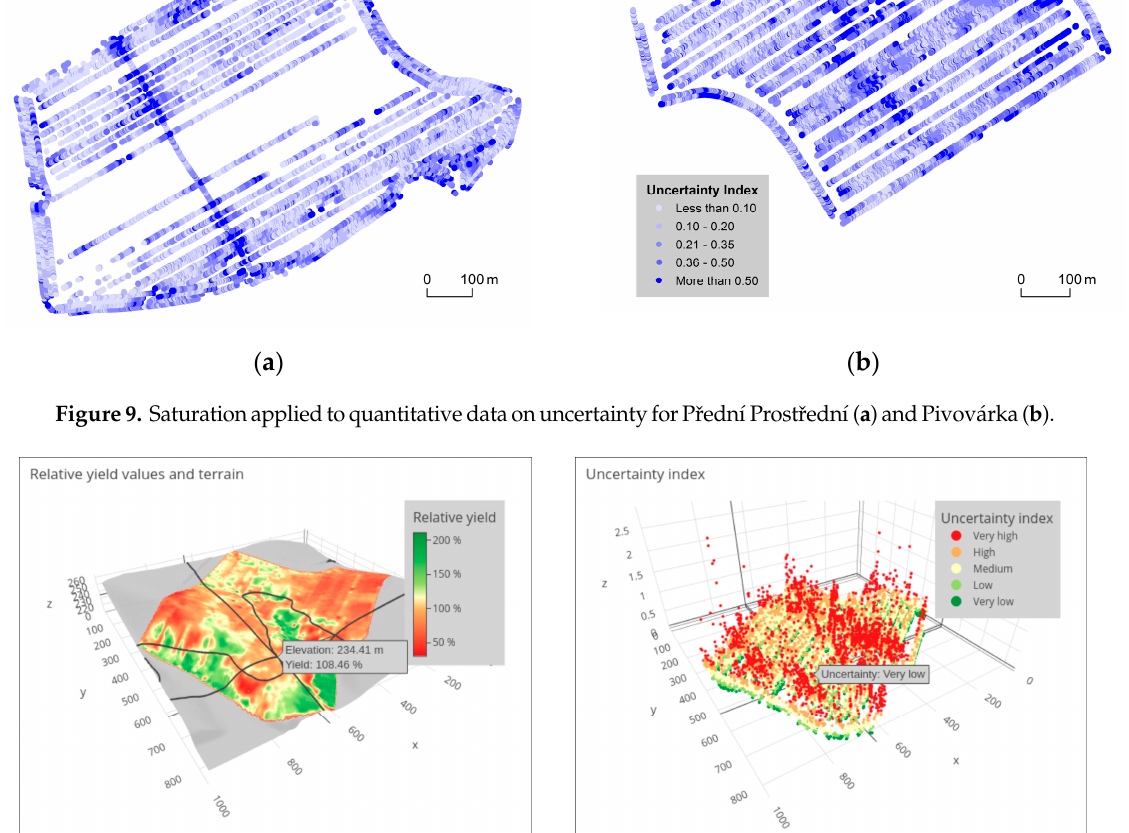
Figure 9. Saturation applied to quantitative data on uncertainty for P ř ední Prost ř ední ( a ) and Pivovárka ( b ).